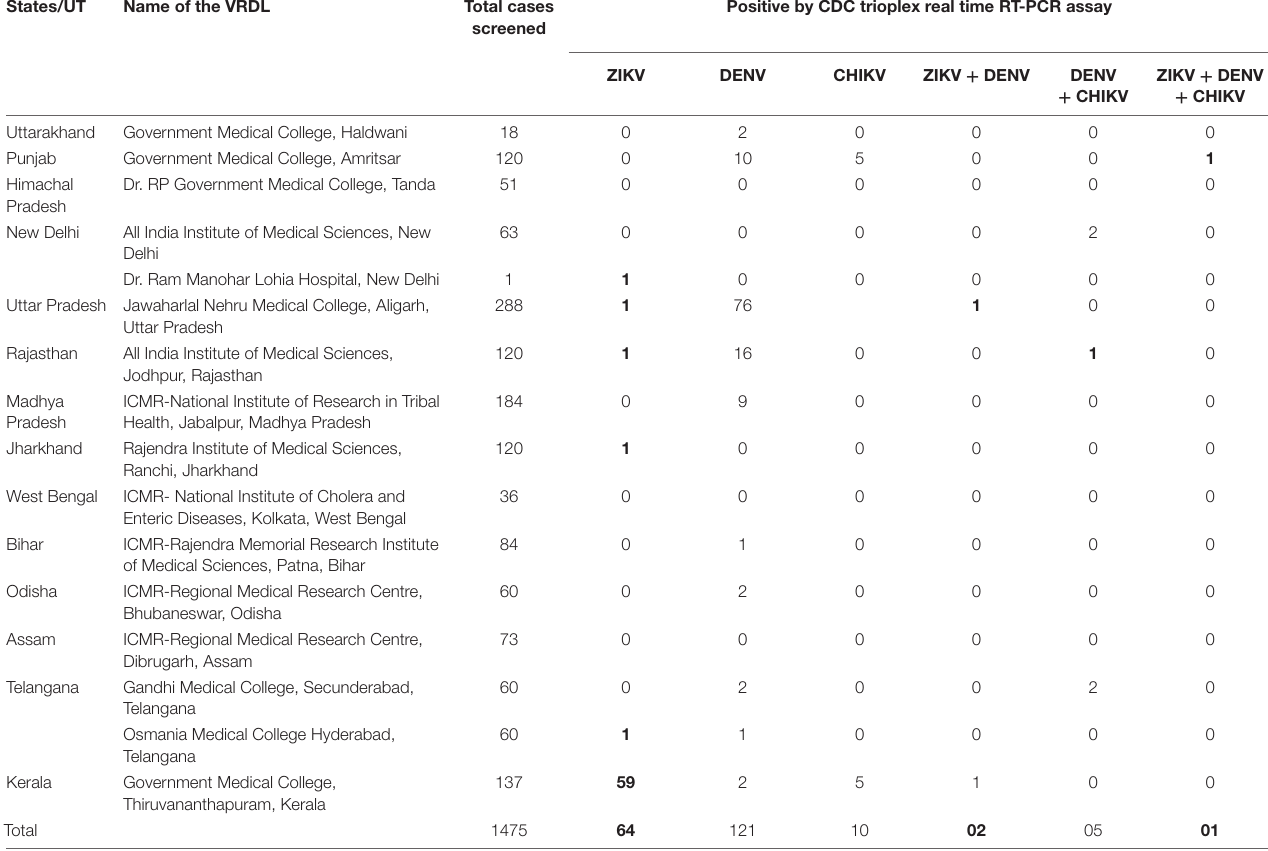
TABLE 1 | Positivity of Zika virus (ZIKV), dengue virus (DENV), and chikungunya virus (CHIKV) disease from different virus research and diagnostic laboratories (VRDLs) in India during May–October 2021.